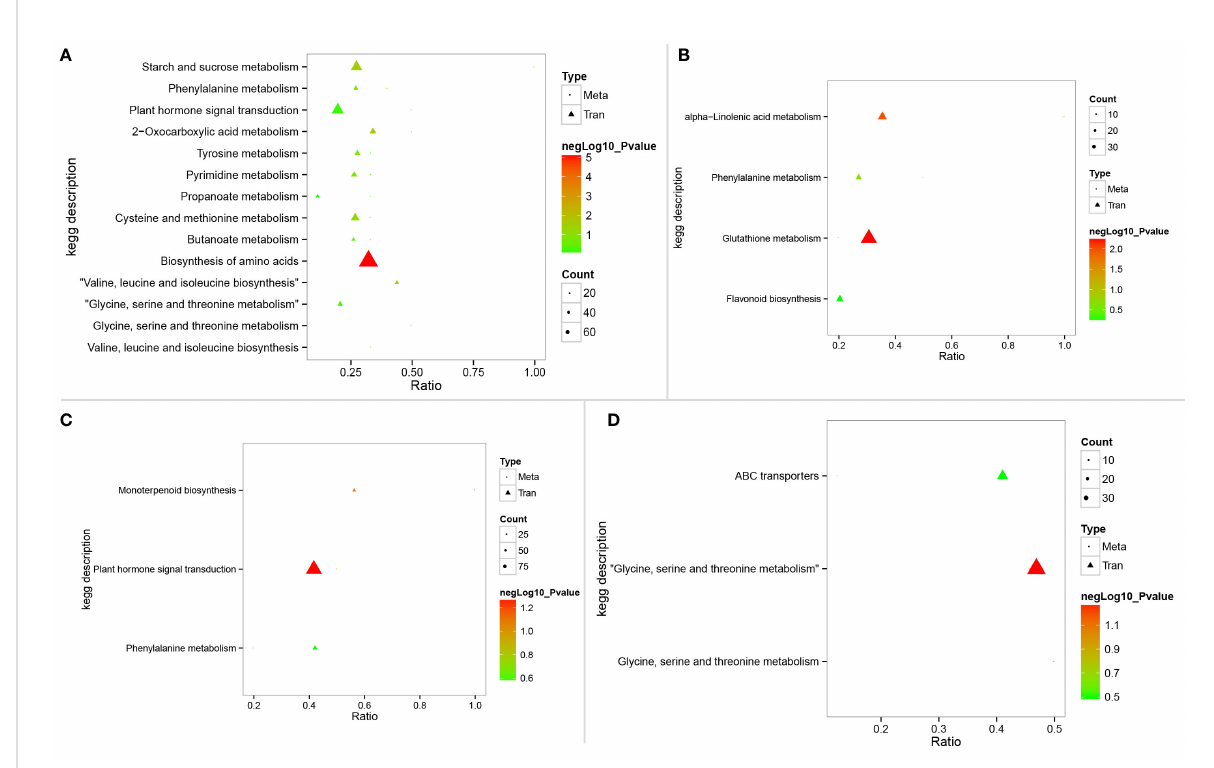
FIGURE 6 KEGG pathways enriched in integration analysis of metabolomics and transcriptomic data. (A – D) represent the KEGG enriched results in SST vs. SSC, STC vs. SSC, STT vs. SST, and STT vs. STC, respectively. STC: LRNK1-Control, STT: LRNK1-Salt treatment, SSC: LR2381-Control, SST: LR2381-Salt